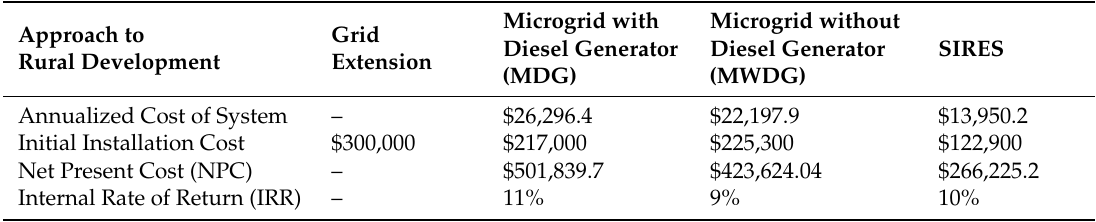
Table 7. Cost Comparison of various Approaches to Rural